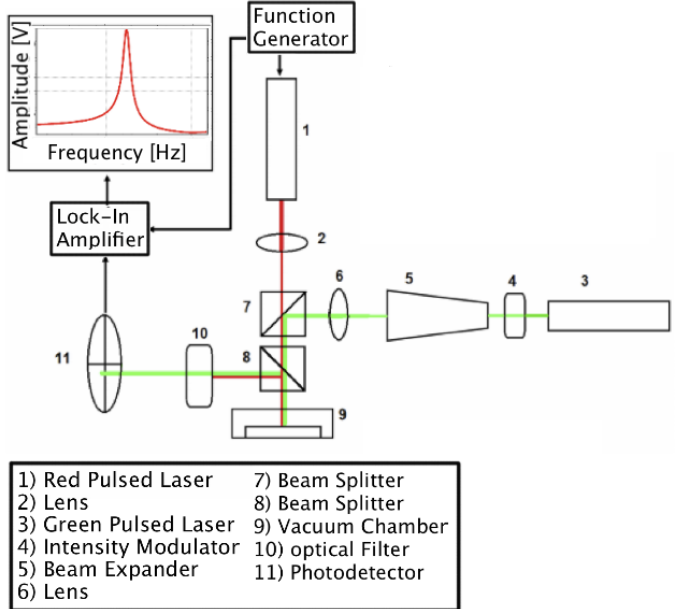
Figure 4. Scheme of the electronic set-up used for the thermogravimetric analysis. The sensor is placed in a vacuum chamber and a pulsed focalized red laser excites cantilever vibrations. A green laser and photodiode are used to read out the cantilever deflections and this information is converted by a lock-in amplifier into a resonance